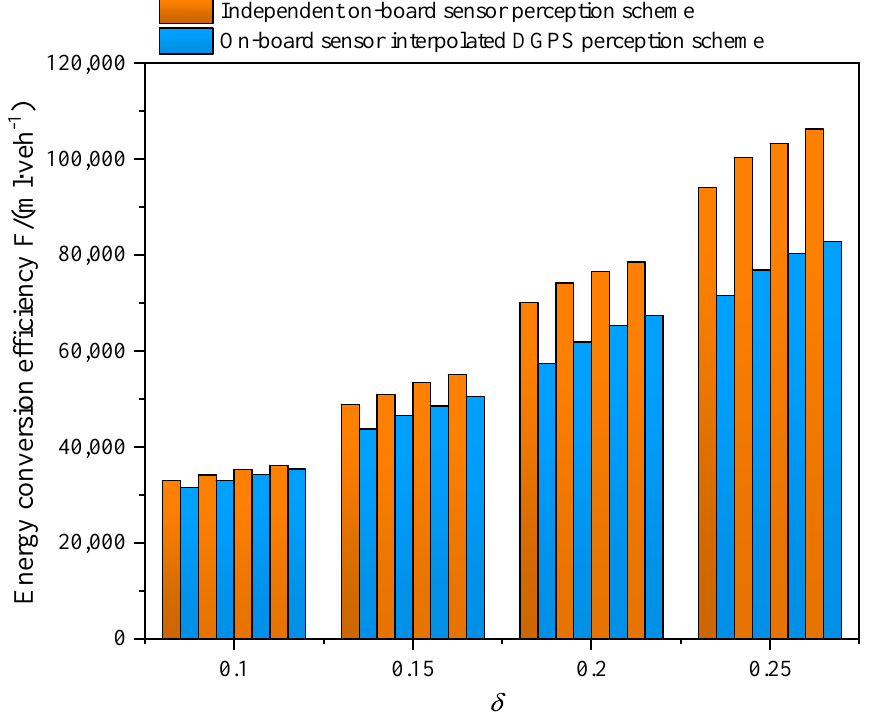
Figure 12. The energy conversion efficiency for varying perceptual error size δ with an independent on-board sensor perception scheme and an on-board sensor interpolated DGPS perception scheme in a partial CAV scenario. The data correspond to 80%, 60%, 40%, and 20% CAV penetration from left to right at each δ